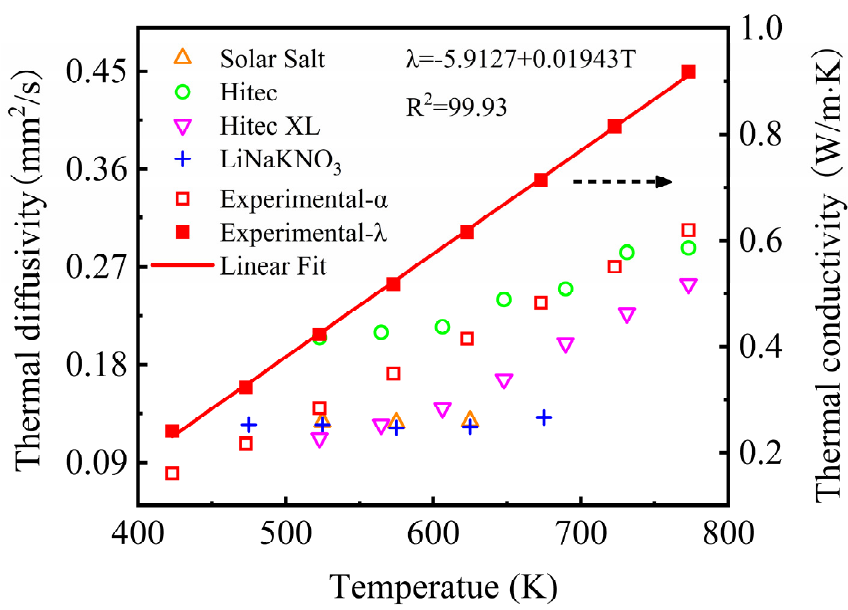
Figure 10. Thermal diffusivity of the NaNO 3 -KNO 3 -Ca(NO 3 ) 2 (16:48:36 wt%) and other currently used nitrate/nitrite systems (left Y -axis); the thermal conductivity of the NaNO 3 -KNO 3 -Ca(NO 3 ) 2 (16:48:36 wt%) (right Y -axis).